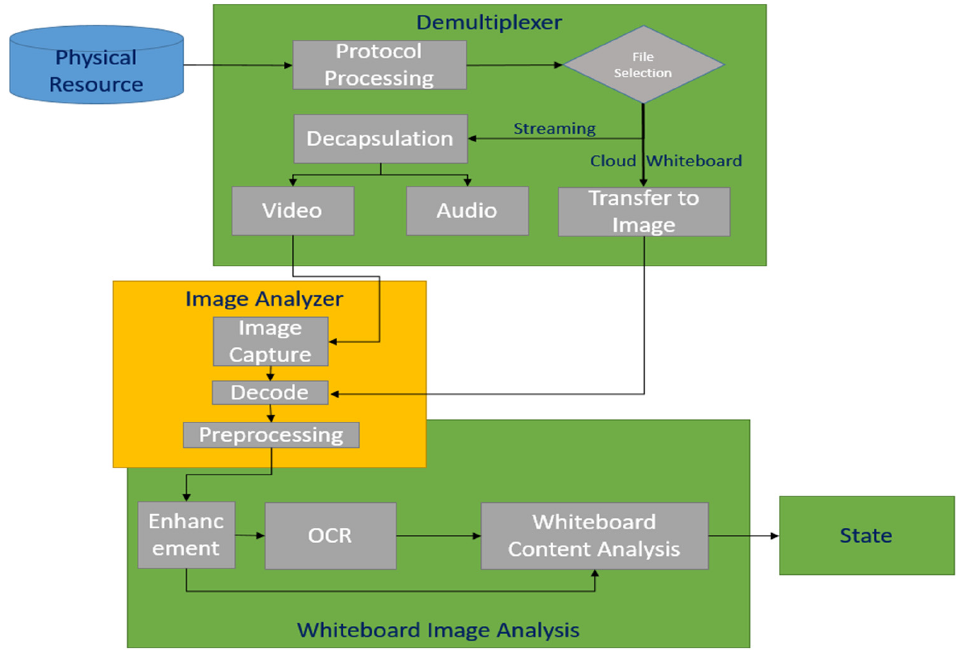
Figure 3. Whiteboard image analysis flowchart.